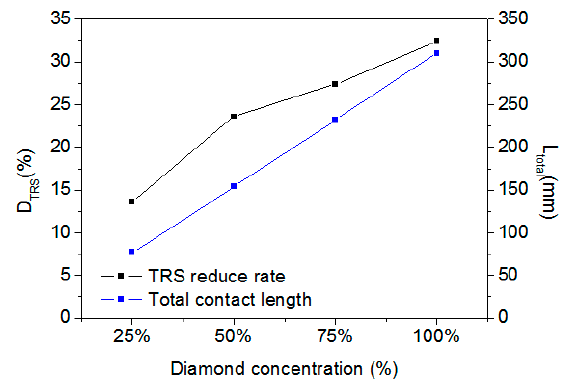
Figure 7. D TRS and total diamond contact length L total versus diamond concentration.